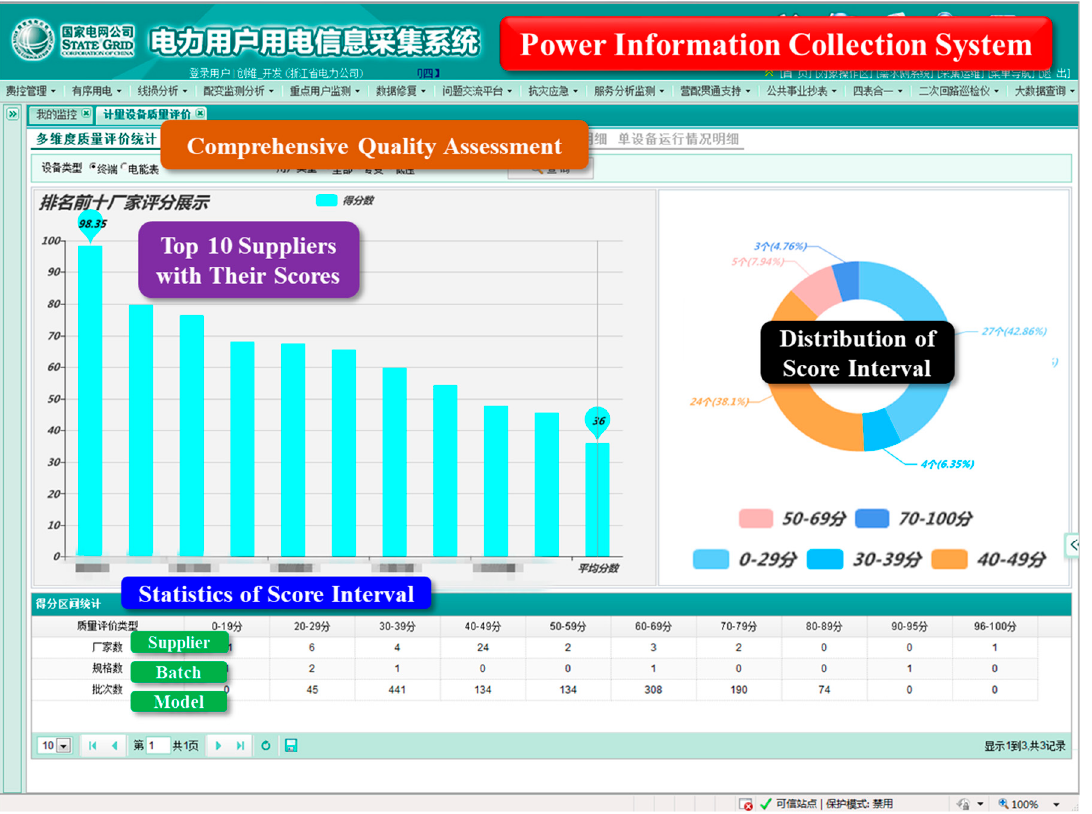
Figure 4. Interface of metering equipment operation quality assessment in electricity information acquisition